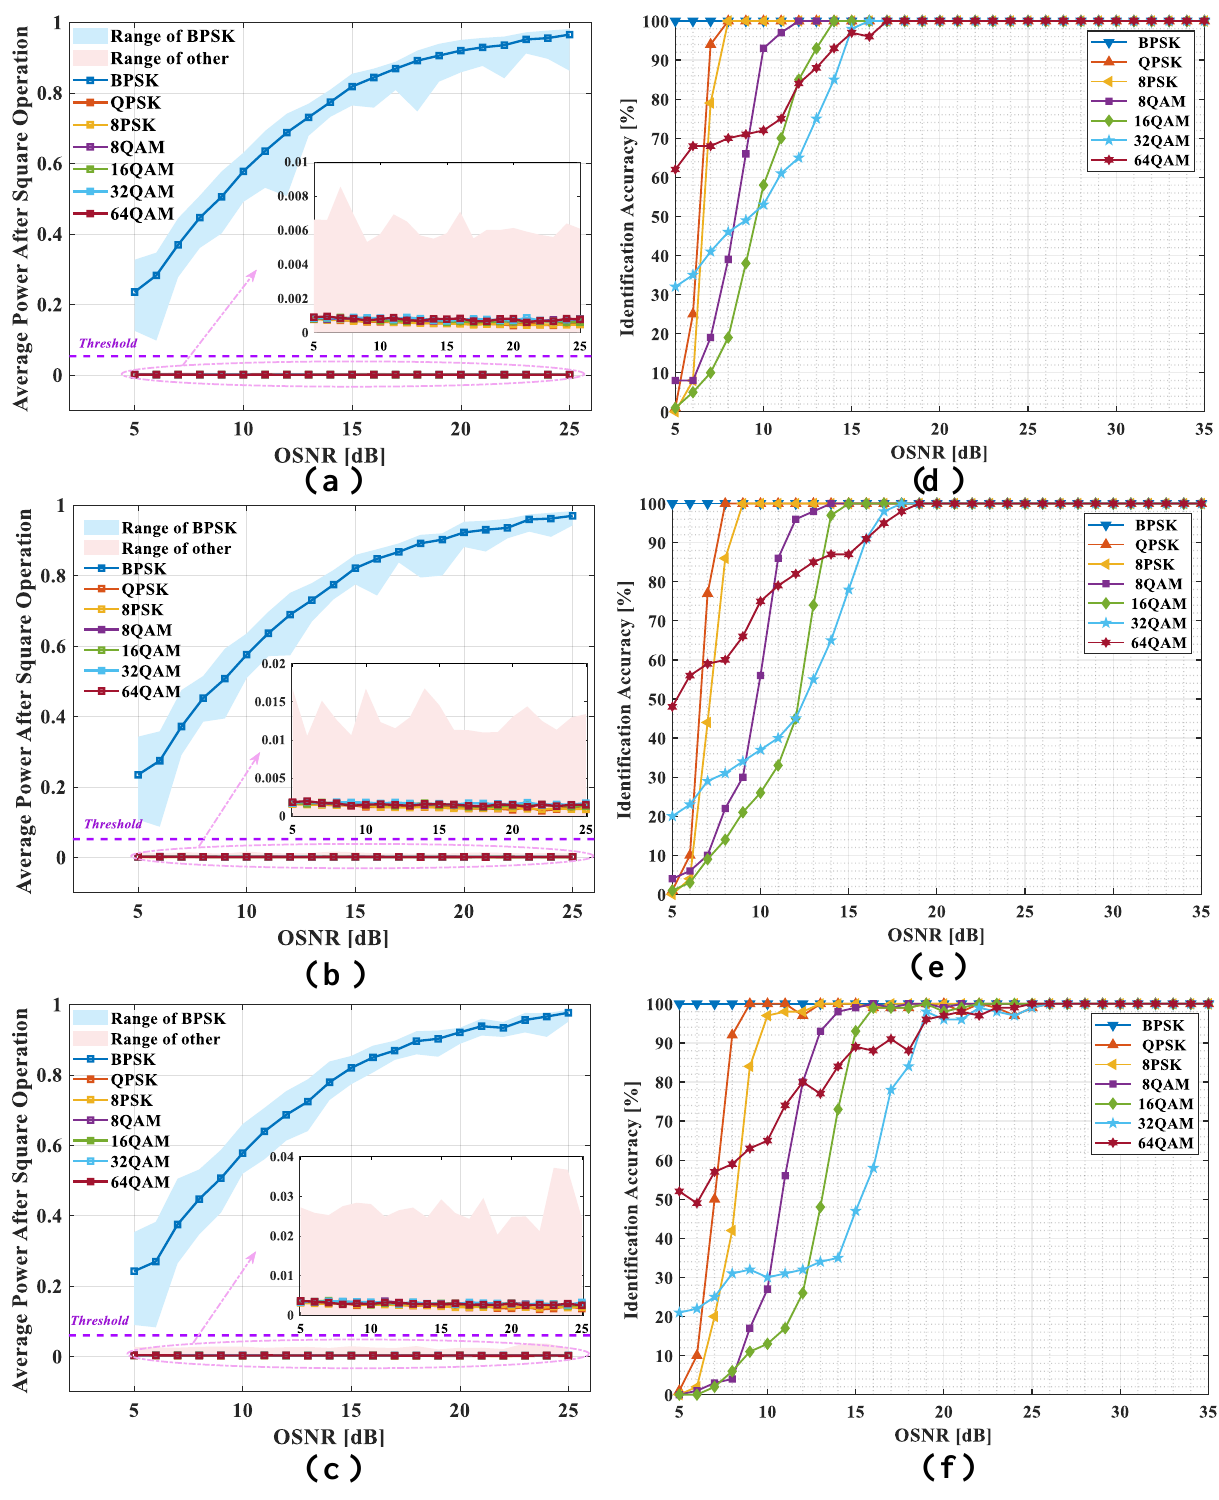
Figure 10. The identification performance under a different number of samples. ( a − c ) The average power of signals after square operation with the number of samples of 2048, 1024 and 512, respectively. ( d − f ) The identification accuracy under 2048, 1024 and 512 samples, respectively.